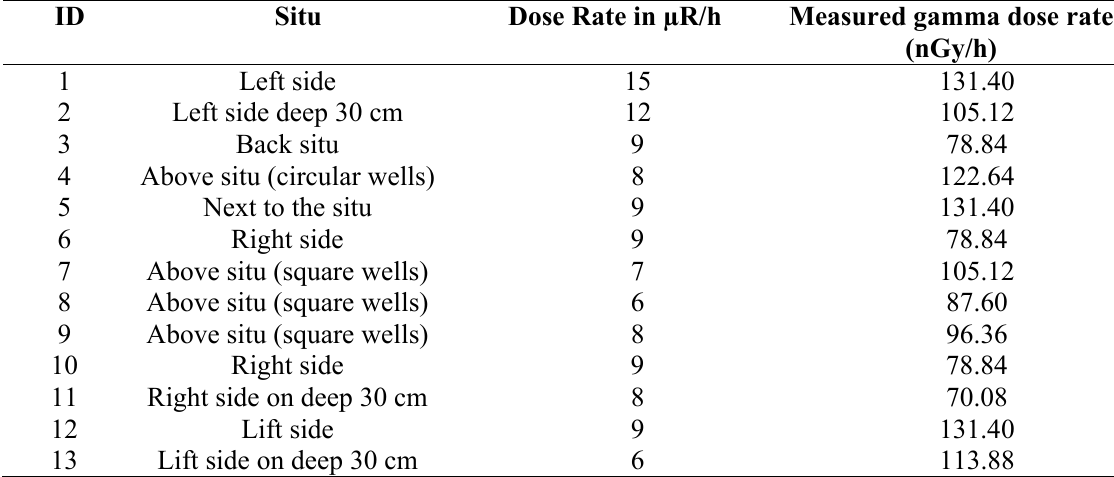
Table 1: The direct measurements of gamma dose rate for the samples collected from a surface and above the RC (nGy/ h).